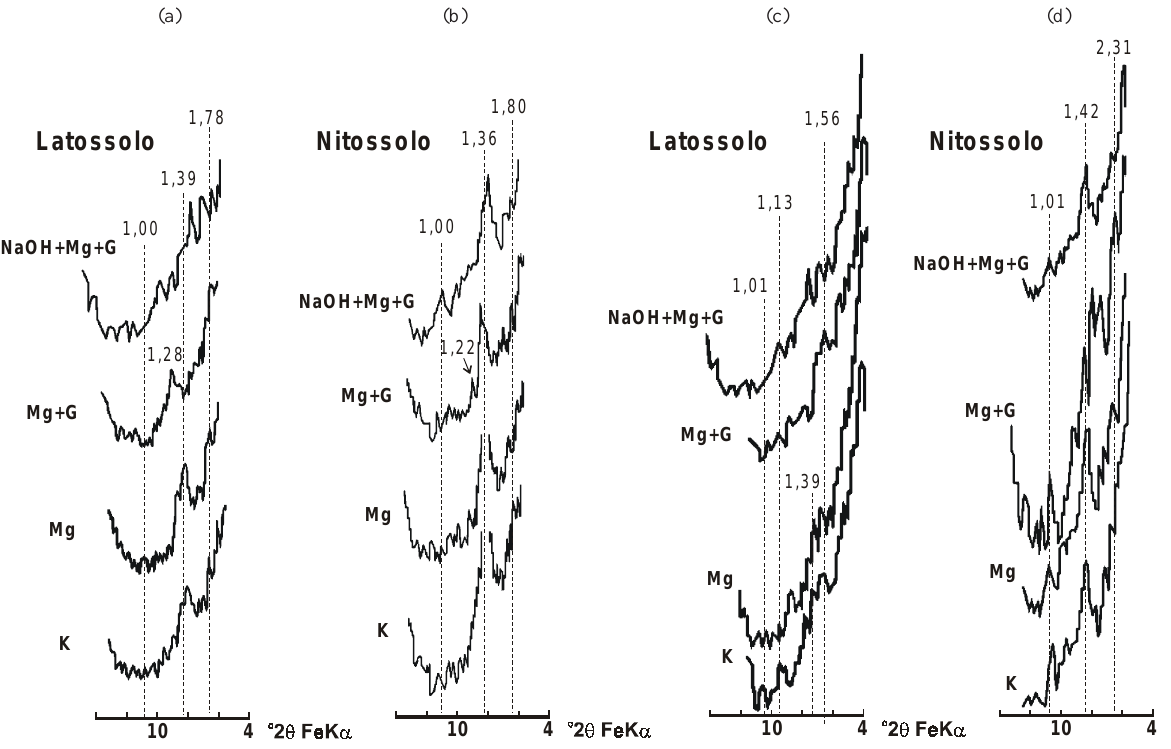
Figura 5. Difratograma de raios-X da fração: argila fina (a e c) e grossa (b e d) desferrificada (espaçamento “d” em nm) do Latossolo (0-0,3 m) e do Nitossolo (0-0,15 m), saturada com K, Mg, Mg + Glicerol e tratada com NaOH 5 mol L -1 fervente, saturada com Mg e solvatada com